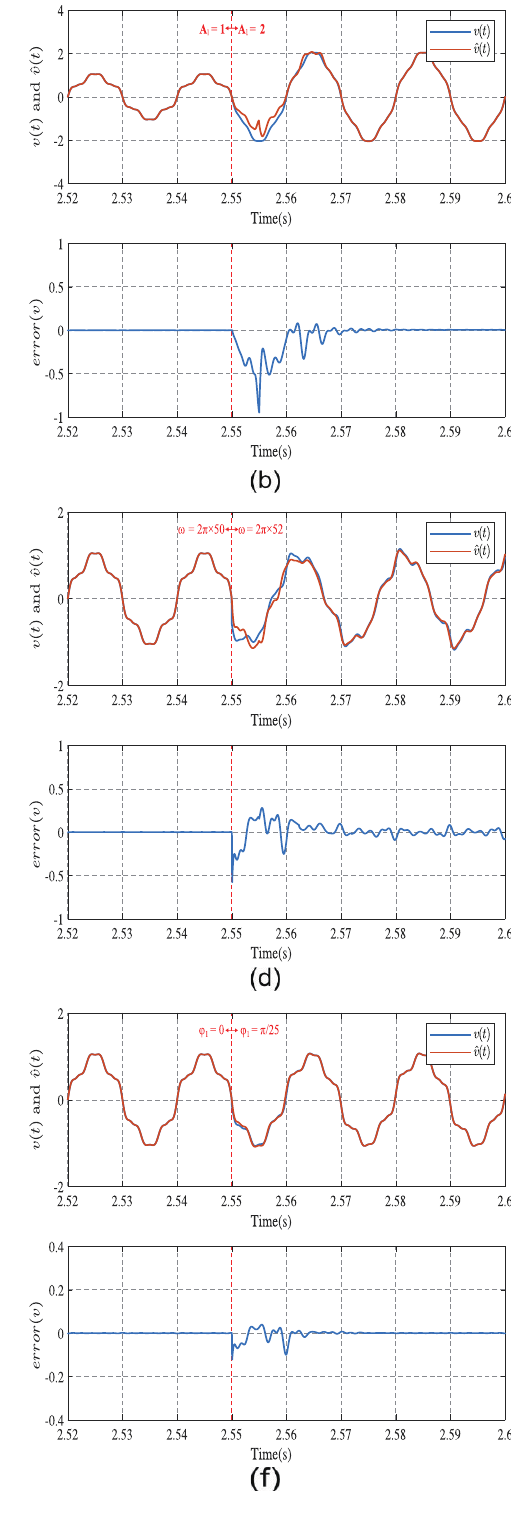
Figure 10. Harmonic observation system detection results for the cascaded 3CS frequency estimation method. ( a , c , e ) Harmonics before and after amplitude, frequency, and phase jumps. ( b , d , f ) Tracking and error before and after amplitude, frequency, and phase